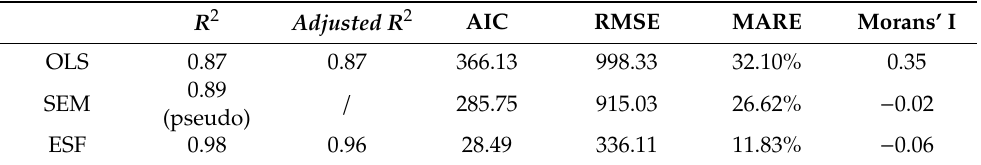
Table 8. Model performance in